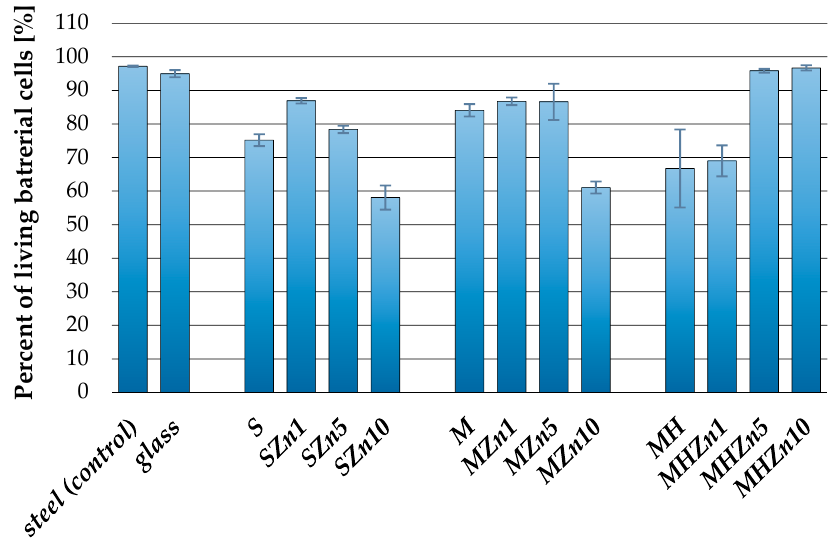
Figure 8. Survivability of bacteria on tested surfaces.